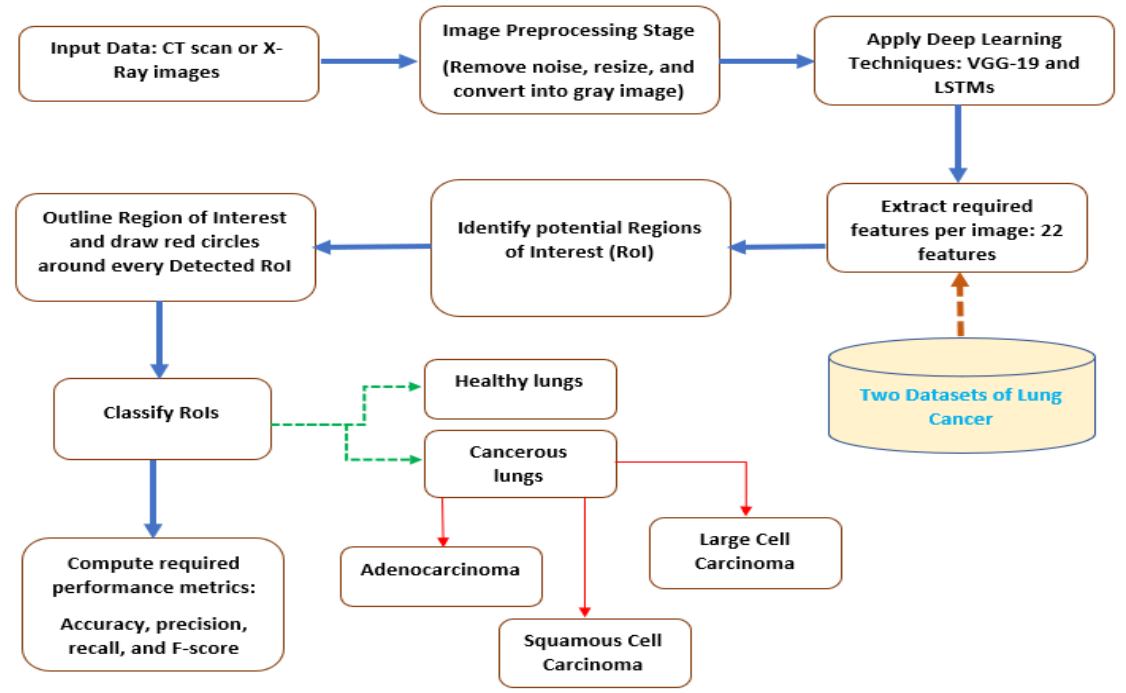
Figure 2. Flowchart of the proposed model . The model starts by preprocessing to remove noise, resize the inputs, and convert all inputs into gray images. Gabor filters and a discrete wavelet transformation method dis- tinguish lung regions and separate these regions from the original images.